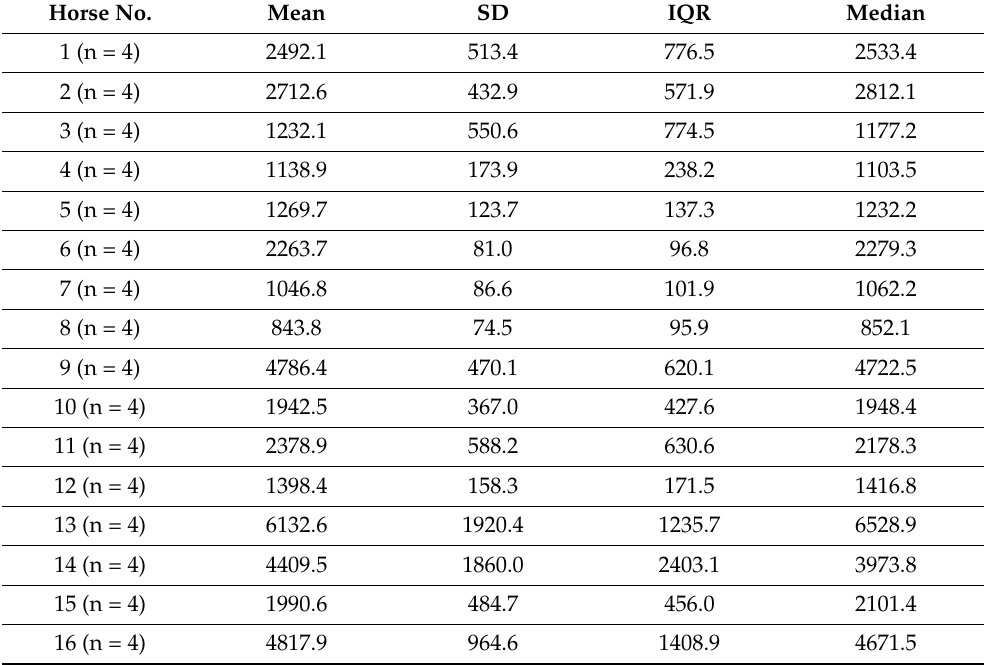
Table 1. SP plasma concentrations in pg/mL of the 16 horses of the experimental group at t0 of 4 different days. Individual mean and median values are shown as well as the intraindividual standard deviation (SD) and interquartile range (IQR).